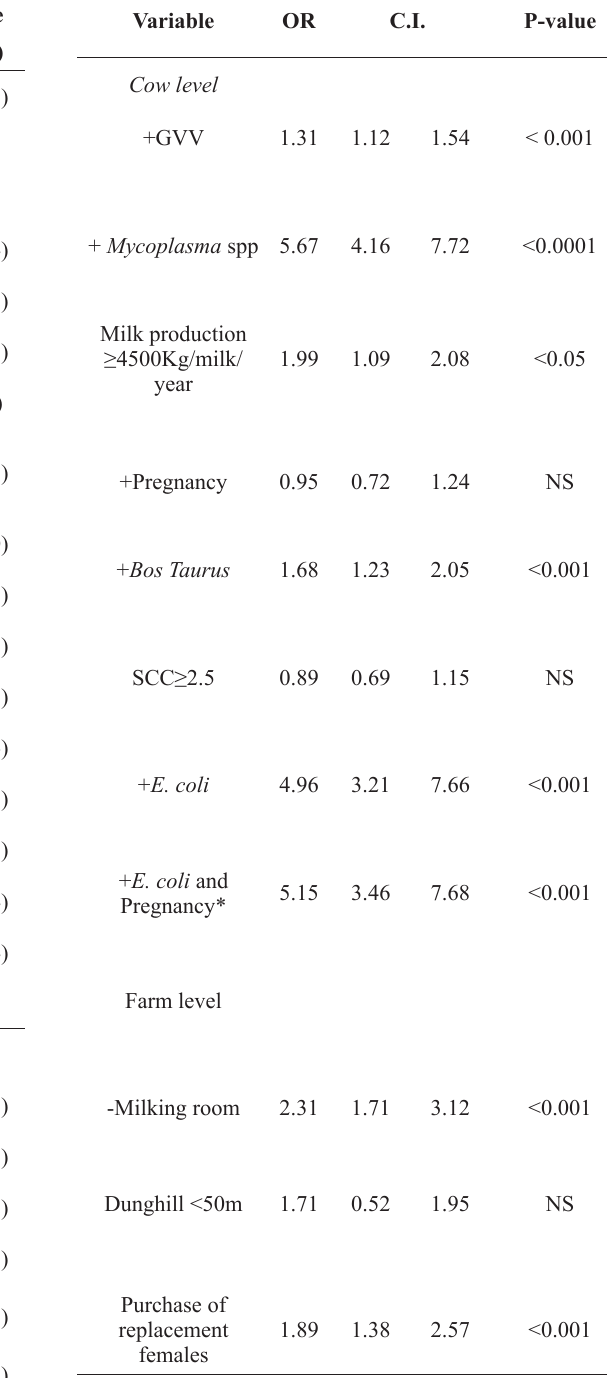
Results of multivariable logistic regression analysis of risk factors between vaginal positive samples to Ureaplasma diversum and independent variables on the 1,238 evaluated cows and 15 dairy farms